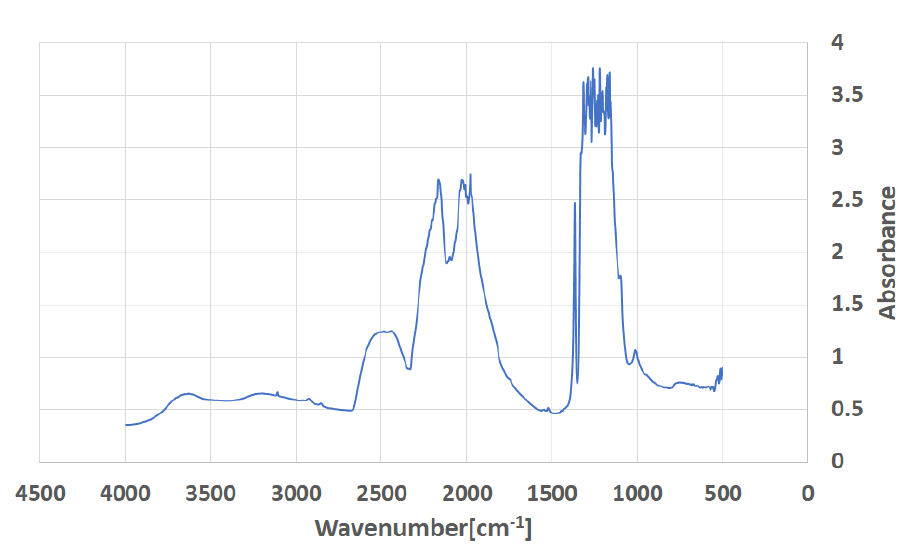
Figure 4. The infrared absorption spectra of the D master diamond. The absorption values at 1095 cm − 1 is 0.09.